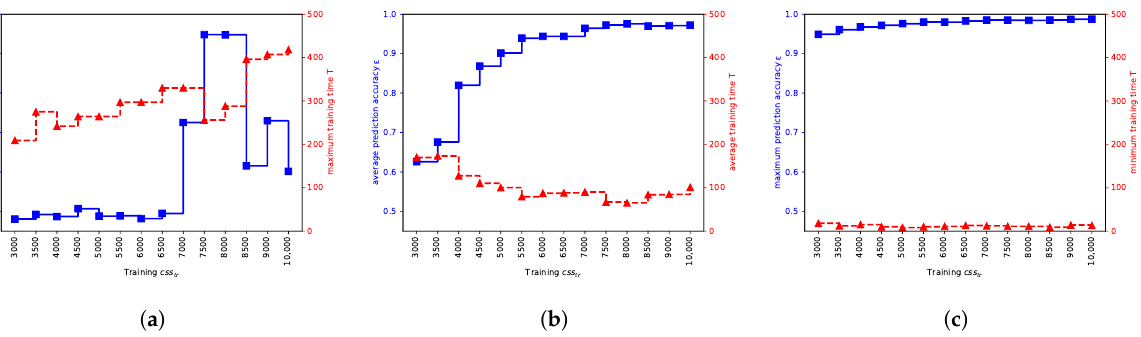
Figure 8. Illustration showing the minimum, average, and maximum training time T and prediction accuracy (cid:101) for various cc tr . ( a ) Max T and Min (cid:101) ; ( b ) average T and (cid:101) ; ( c ) Min T and Max (cid:101)